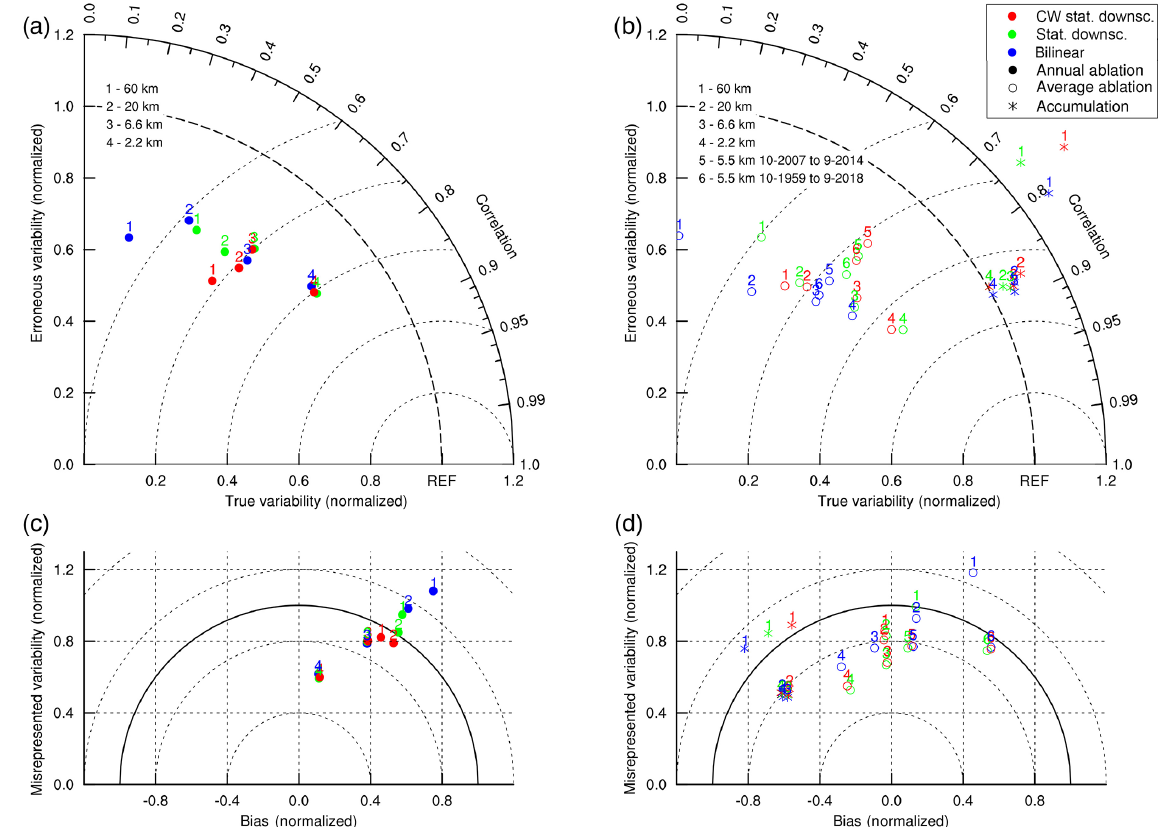
Figure 7. Graphical representation of the statistics of refined RACMO2 data for (a, c) exact time-matching ablation observations and (b, d) all ablation (circles) and accumulation (stars) observations. Panels (a, b) are Taylor diagrams; panels (c, d) show the contribution of the bias (horizontal axis) and misrepresented variability (vertical axis) to the RMSD (circles around ( 0 , 0 ) ). All data in this figure are scaled with the standard deviation of the observation dataset. The 5.5km data are taken from Noël et al. (2019). The legend in (b) , upper right corner, applies to all